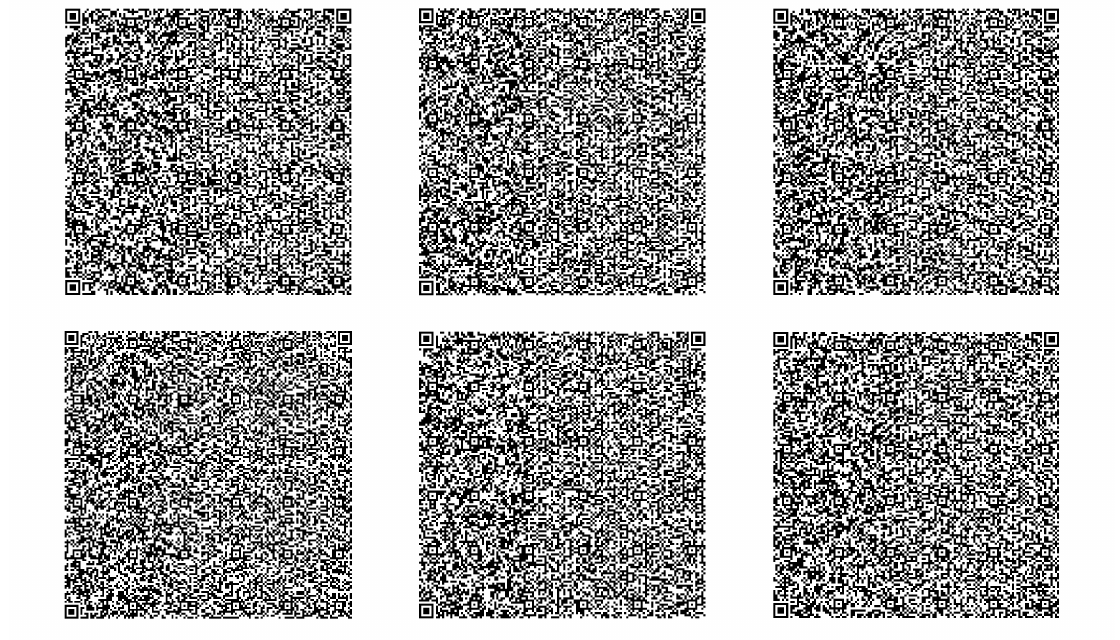
Figure A5. QR codes with the positions ( x , y ) and excitations ( a ) of the radiators for the 622 elements sparse layout. The position and excitations have been split in two sub-vectors ( x = [ x 1, x 2 ] , y = [ y 1, y 2 ] , a = [ a 1, a 2 ]